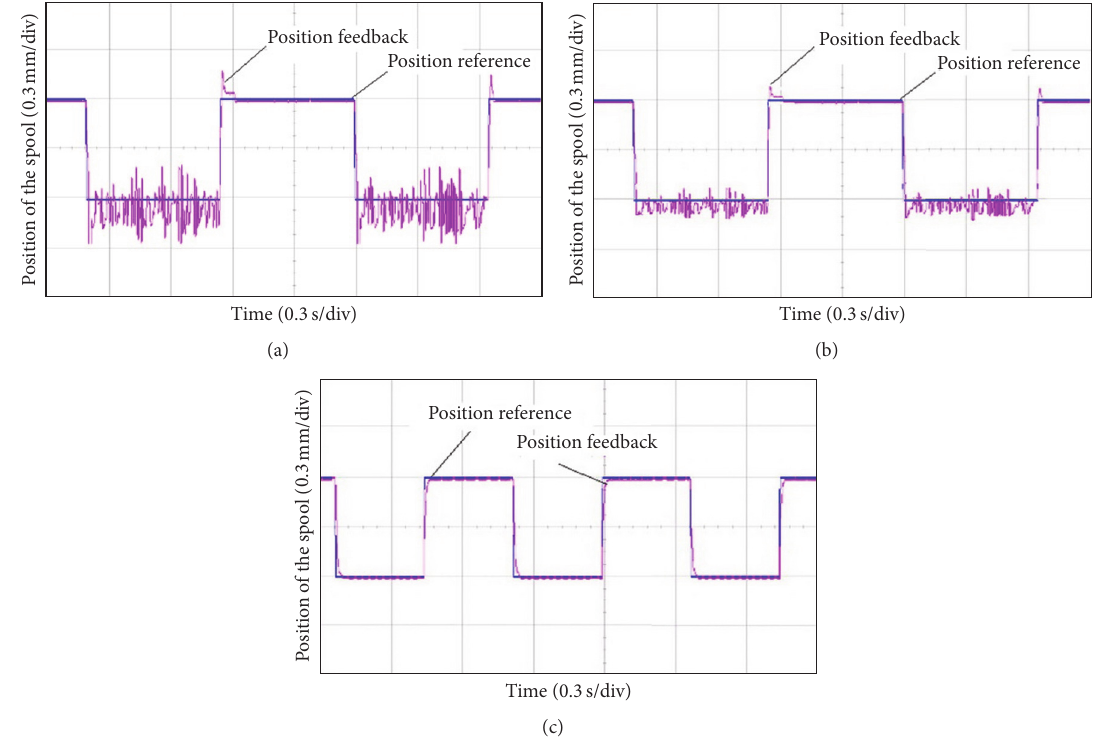
Figure 10: Experimental results of square trajectory tracking (a) using conventional PID control, (b) using RBF-PID method, and (c) using RBF-ESO method.